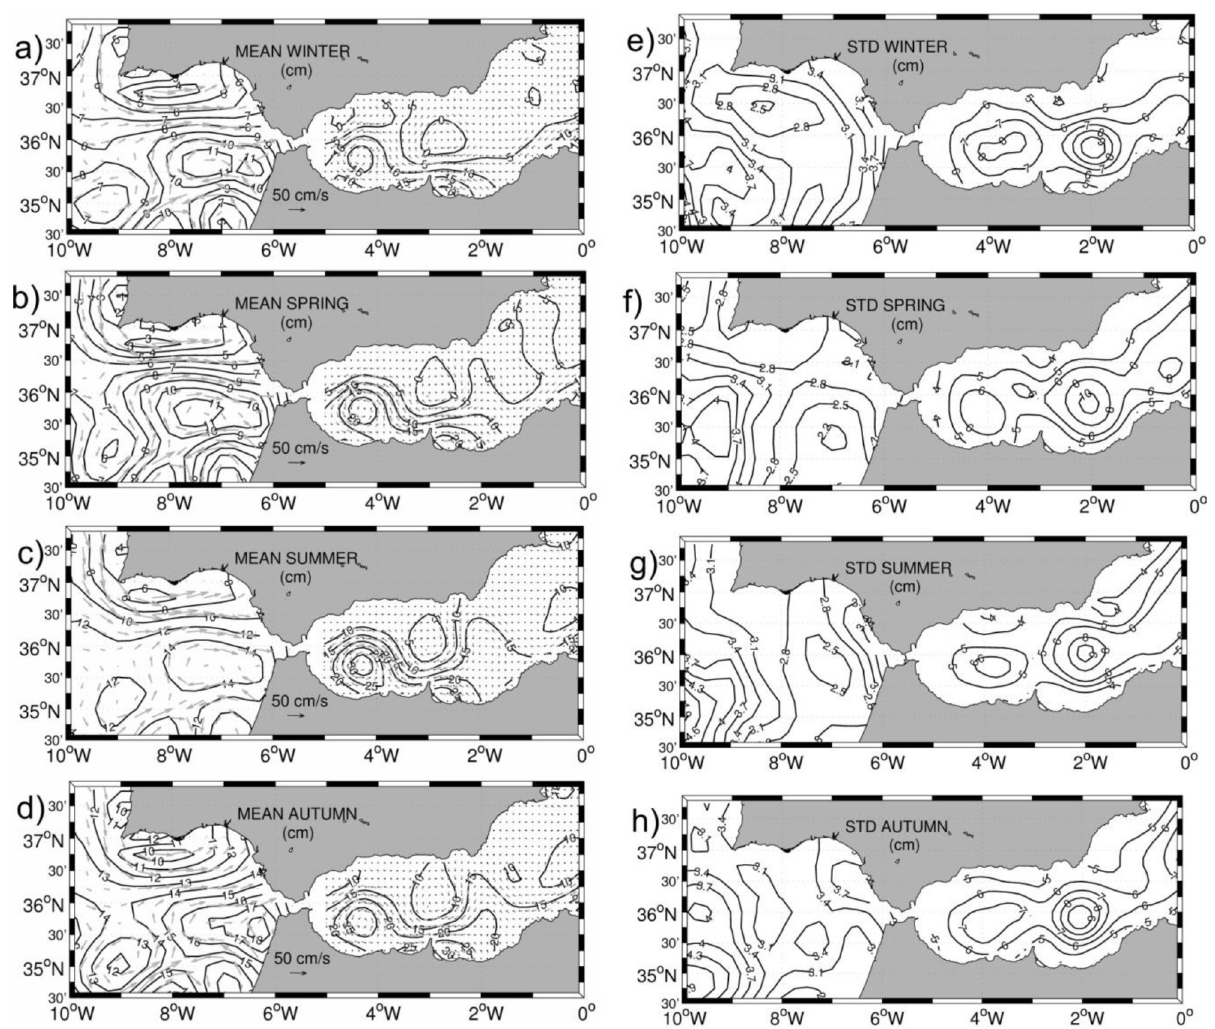
f iG . 4. – Same as Figure 3 for season data subsets, according to the legend at the top of the